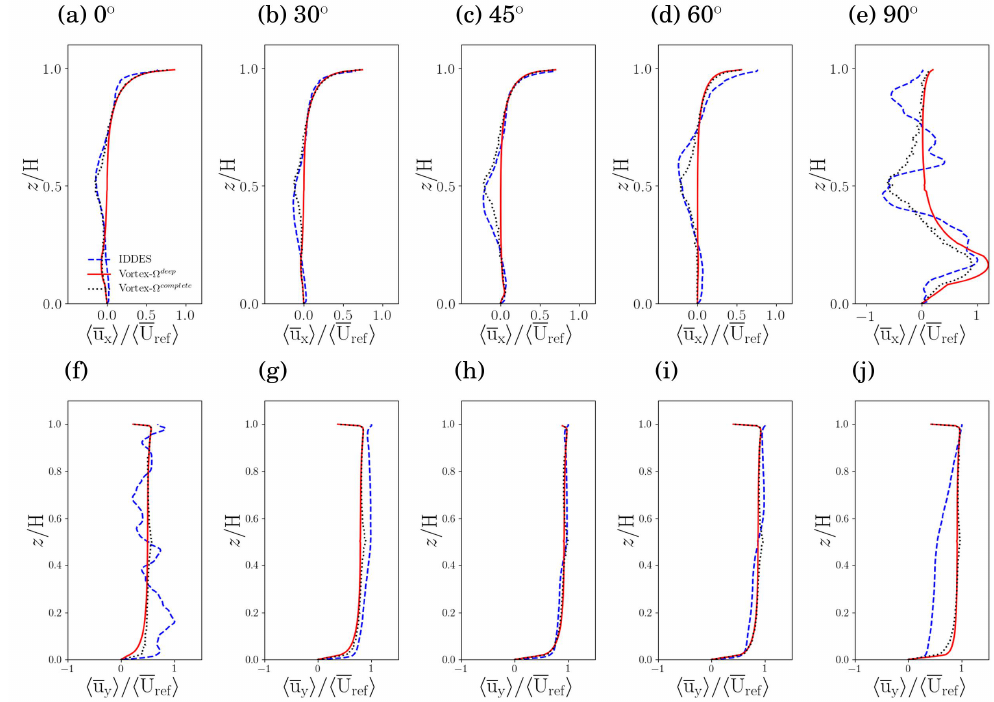
Figure A1. ( a – j ) Vertical profiles of normalised velocities within the deep canyon ( AR = 3) for the complete set of vortex sheets Ω complete (black dotted line), the reduced set Ω deep (red line), and the IDDES baseline (blue